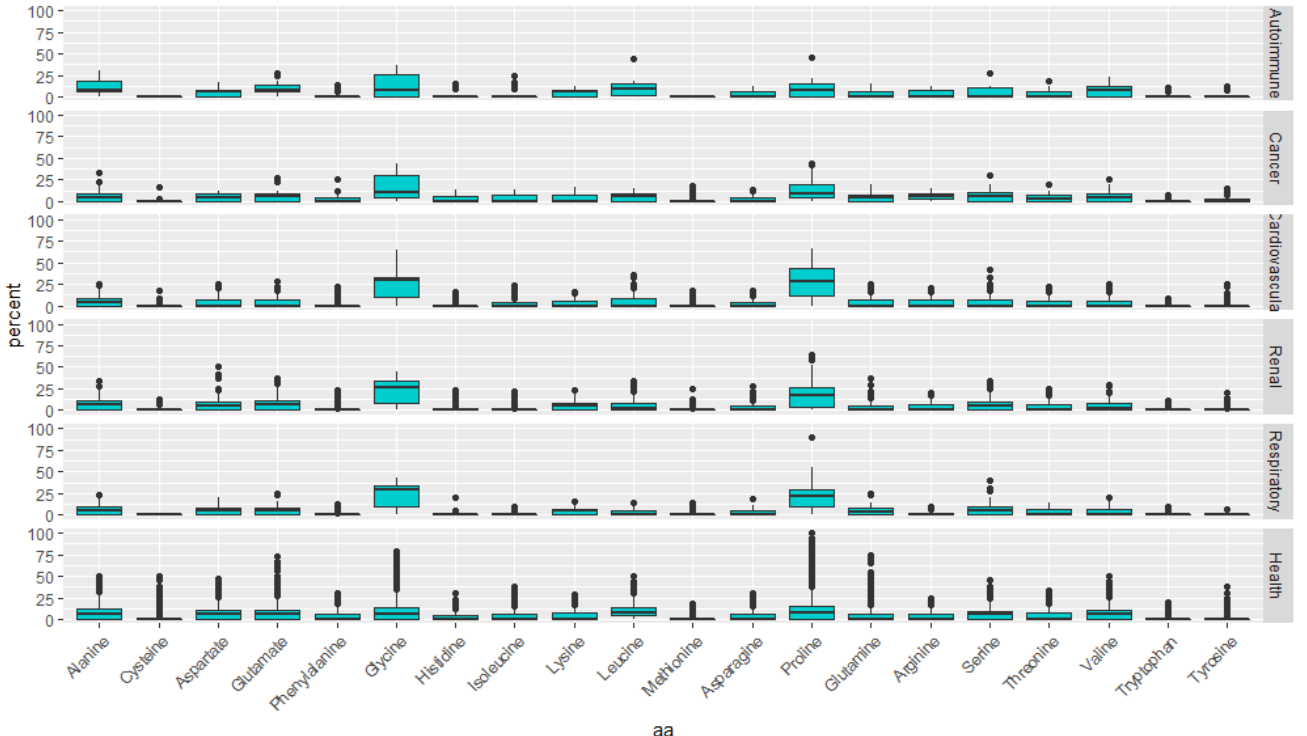
Figure 2. Amino acid composition of each disease class’ “signature” peptides.